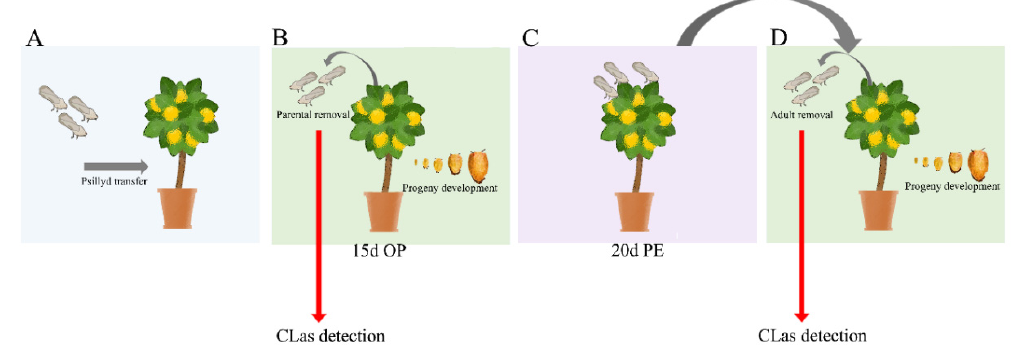
Figure 1. Scheme of Candidatus Liberibacter asiaticus (CLas) acquisition assay over multiple Asian citrus psyllid (ACP) generations. CLas-free ACP adults were transferred to CLas -infected citrus plants ( A ). After a 15-day oviposition period (OP), adults were removed and the progeny development was monitored ( B ). Progeny was kept on those plants for 20 days after the emergence of adults (post-emergence—PE) for a new oviposition cycle ( C ). After this period, the adults were removed and the progeny development was monitored and maintained for 20 days (PE) for oviposition of the next ACP generation ( D ). This cycle was repeated four times (four ACP generations). ACP adults removed from CLas-infected plants in each generation were stored at − 80 °C for CLas detection by qPCR.